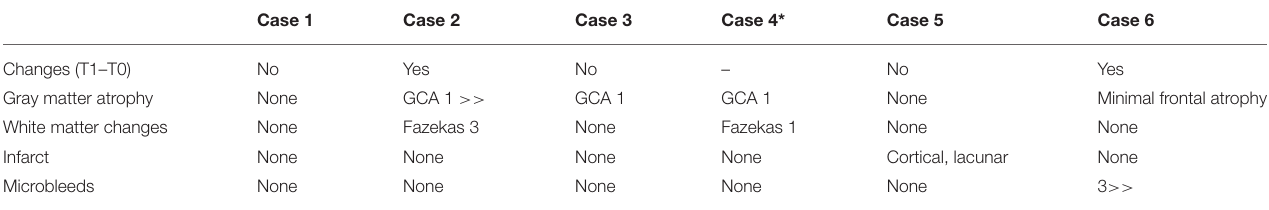
TABLE 3 | Summary of follow-up radiological assessment for each phFTD